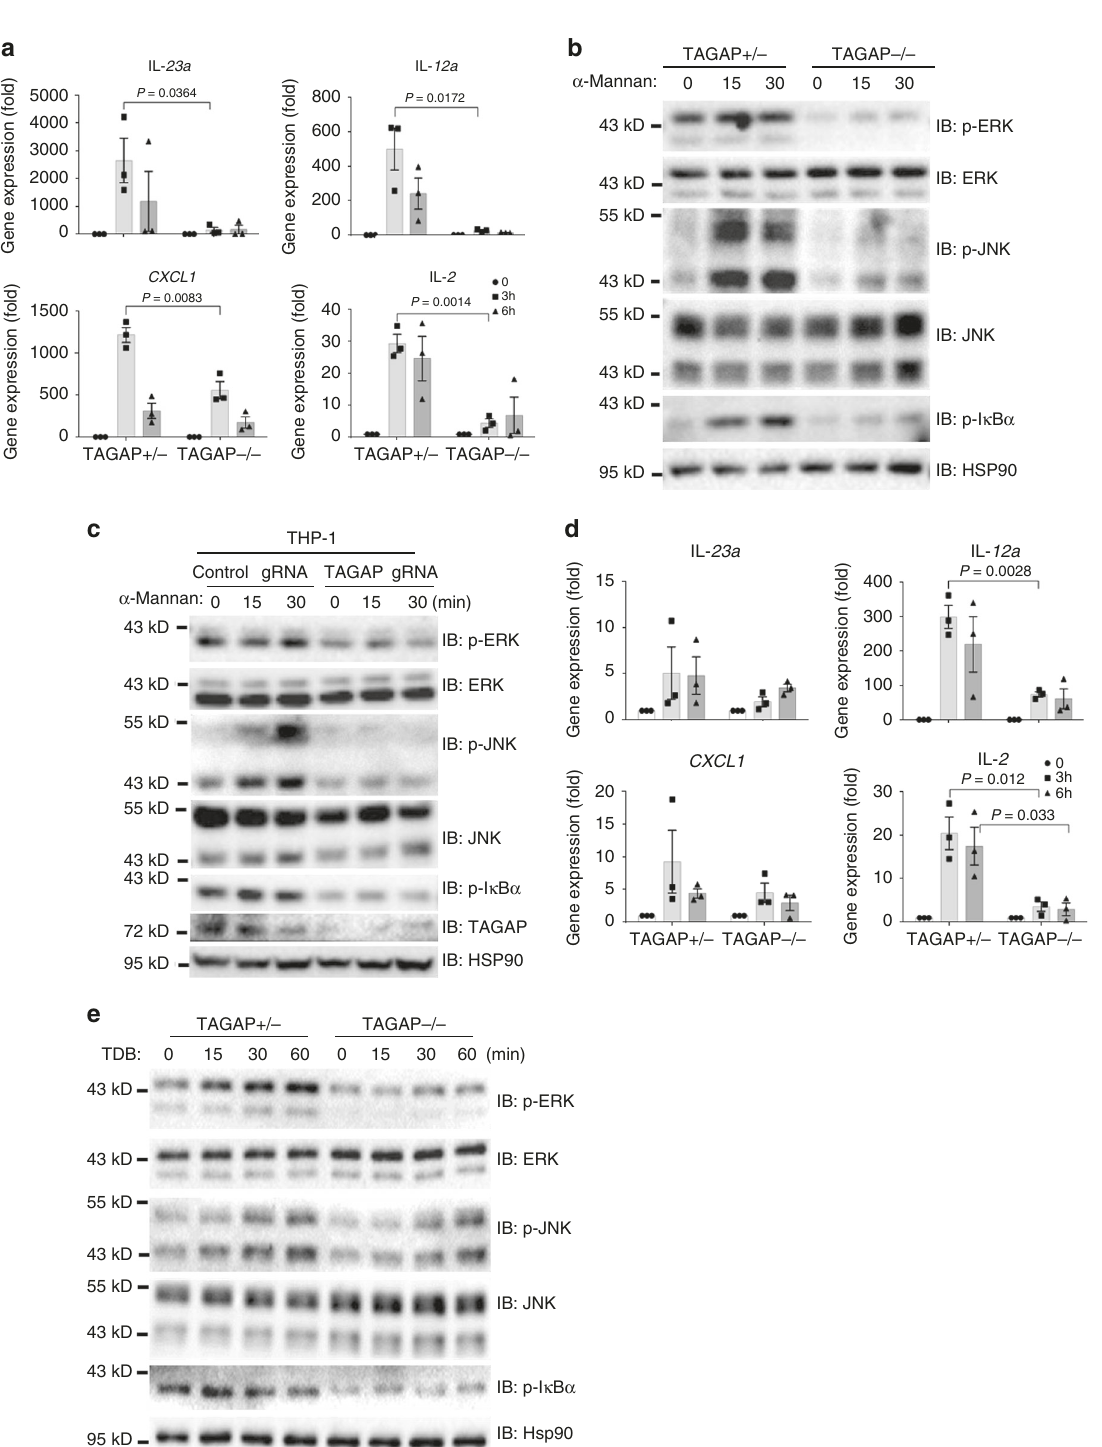
Fig. 2 TAGAP is required for Dectin-2/3 and mincle ligands-induced signaling activation. a BMDMs from heterozygous control mice or TAGAP- de fi cient mice were stimulated with α -Mannan (100 μ g/ml) for 3 and 6 h, followed by real-time PCR analysis of indicated genes. b BMDMs from heterozygous control mice or TAGAP-de fi cient mice were stimulated with α -Mannan (100 μ g/ml) for indicated times, followed by western blot analysis of indicated protein expression. c Control- gRNA or TAGAP-gRNA knocked down THP-1 cells were stimulated with α -mannan (100 μ g/ml) for indicated times, followed by western blot analysis of indicated proteins. d BMDMs from heterozygous control mice or TAGAP-de fi cient mice were stimulated with TDB (50 μ g/well) for 3 and 6 h, followed by real-time PCR analysis of indicated genes. e BMDMs from heterozygous control mice or TAGAP-de fi cient mice were stimulated with TDB (50 μ g/well) for indicated times, followed by western blot analysis of indicated protein expression. * P < 0.05; ** P < 0.01; *** P < 0.001 based on two-sided unpaired t test a , d . All error bars represent SEM of technical replicates. Data are representative of three independent